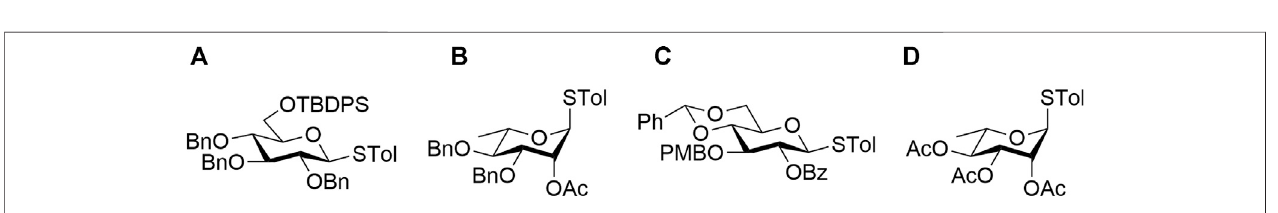
FIGURE 3 | Thioglycoside donor building blocks (A – D)